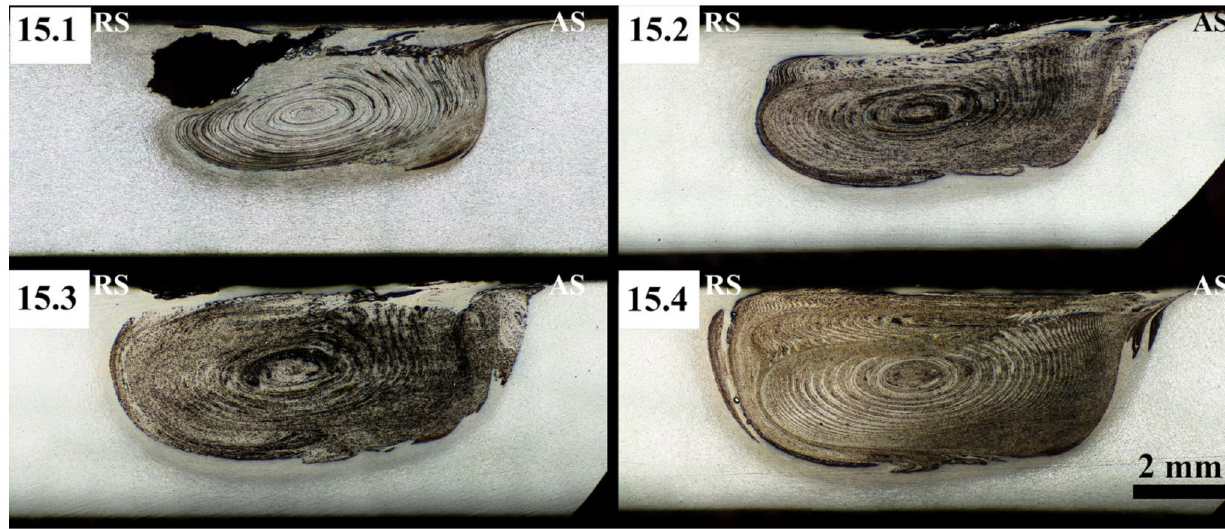
Figure 6. Al-Mg-Sc alloy macrostructure after FSP with 15 wt% Mo after 1–4 passes (samples 15.1–15.4). AS–advancing side, RS–retreating